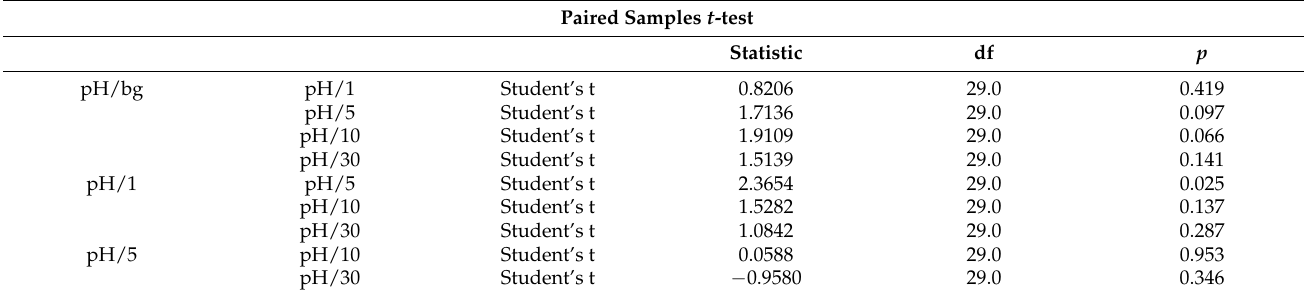
Table 4. Within-the-group comparison of pH at different time intervals.